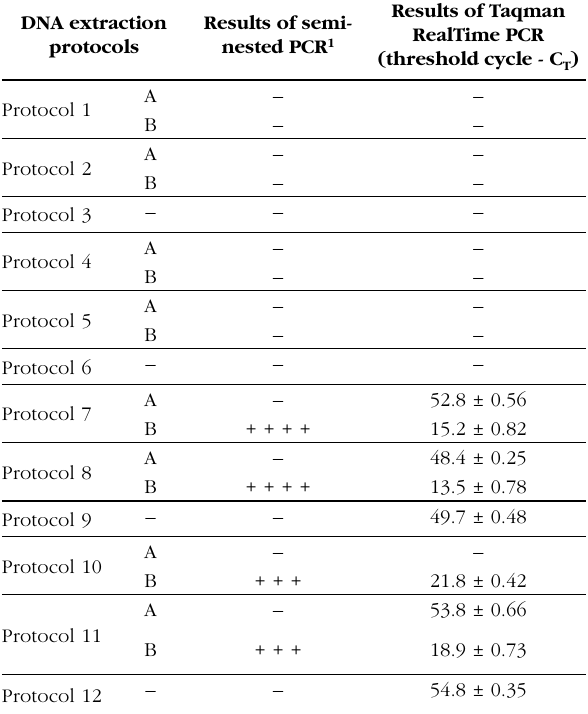
table ii. – comparative efficiency of various G. intestinalis cysts undiluted treatments prior to dnA extraction with the use of twelve protocols, measured with Pcr signal of product of the β -giardin gene ) of real time Pcr (18s rrnA and treshold cycle (c t